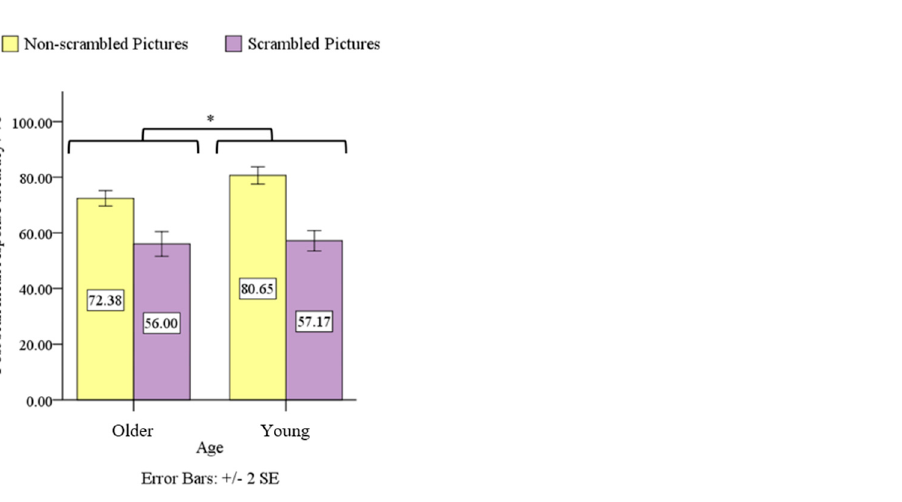
Figure 4. Age × condition mixed design ANOVA on post-scan ACC revealed significant interaction e ff ect, main e ff ects of age and condition, at p < 0.05 *.